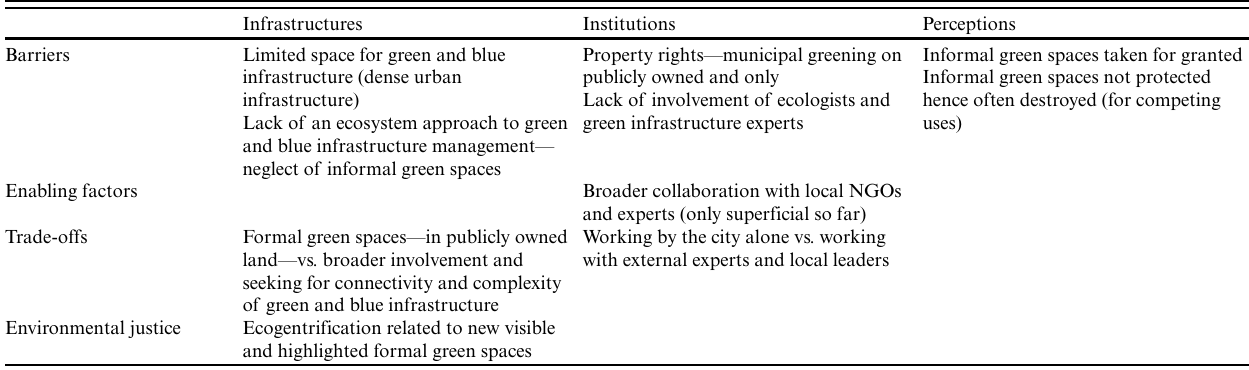
Table 6. ENABLE filters mediating the flow of benefits from GBI to potential beneficiaries translated into an analytical framework for the assessment of GBI-related initiatives— in the case of Green Polesie urban renewal project in